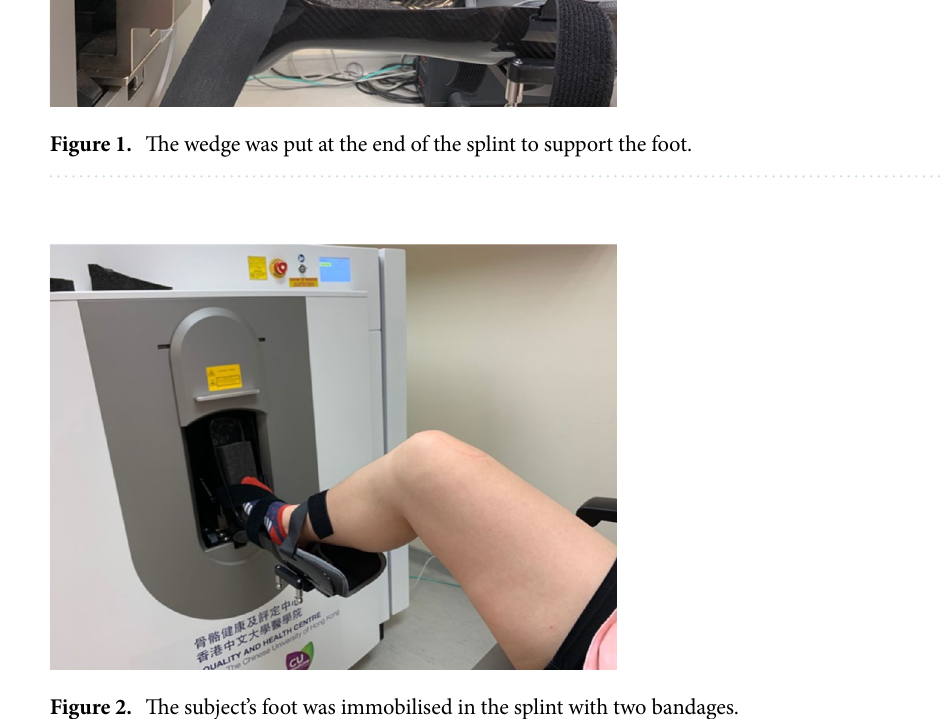
Figure 2. The subject’s foot was immobilised in the splint with two